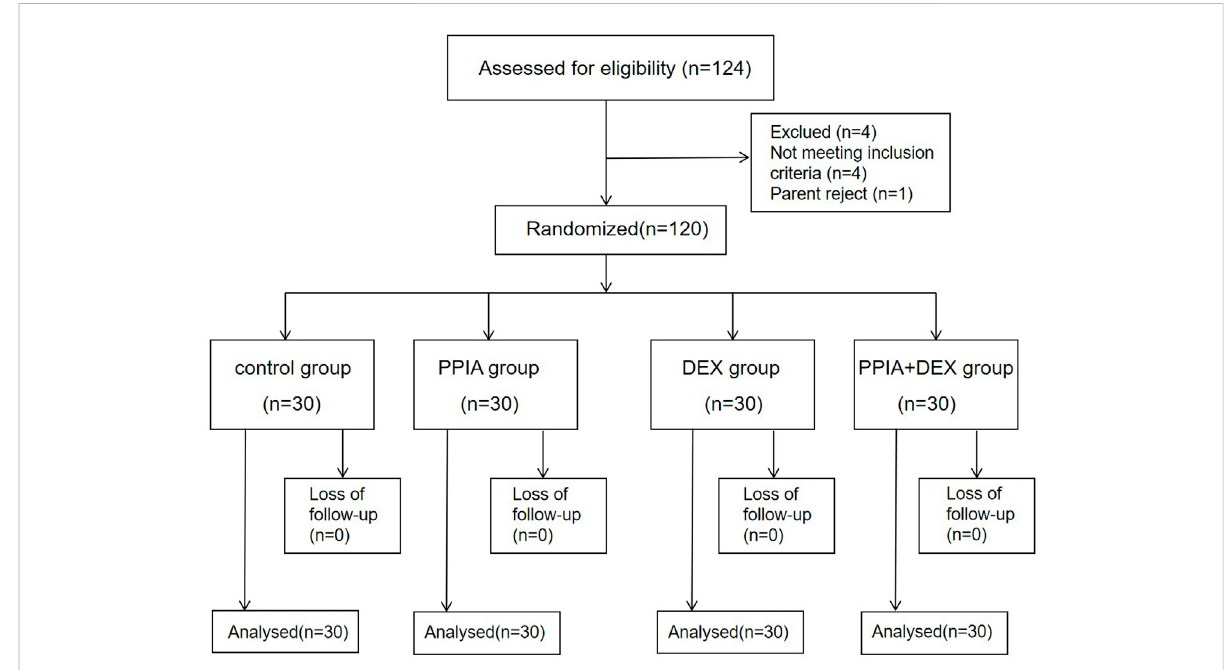
FIGURE 2 Study fl ow diagram. PPIA: parental presence during induction of anesthesia. DEX: intranasal dexmedetomidine.